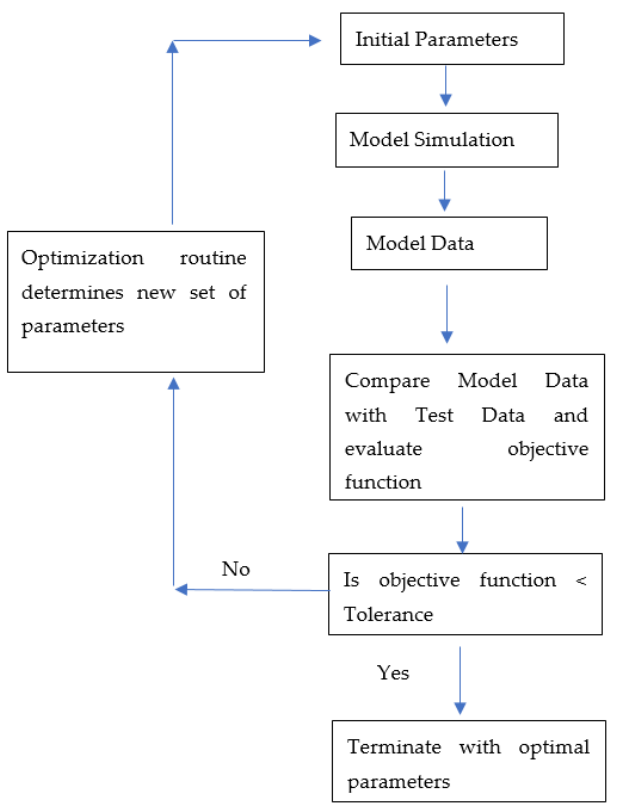
Figure 4. Flow chart of the optimization process.